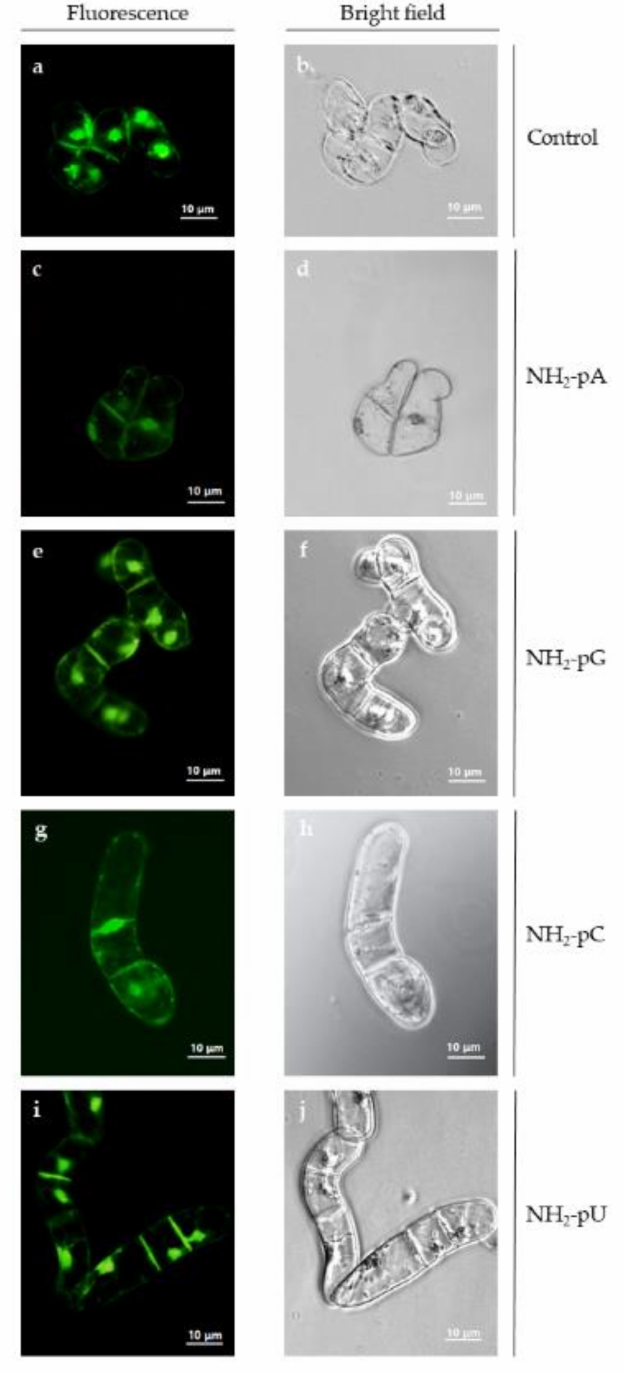
Figure 6. Viability of Vitis vinifera cell suspension culture treated with 5 µ M NH 2 -pNs at 72 h. It was evaluated by incubating cells in the presence or absence of the indicated nucleotide for 1–2 min in fresh Gamborg medium using the Plant Cell Viability Assay Kit (Sigma-Aldrich, Burlington, MA, USA) as described in the Section 4. Fluorescence was observed with an AxioVert 200 Carl Zeiss microscope using a Zeiss filter (FS09 exc = 495 nm, emi = 517 nm). ( a , b ) control cells; ( c , d ) cells treated with NH 2 -pA; ( e ) and ( f ) NH 2 -pG; ( g , h ) NH 2 -pC; ( i , j ) NH 2 -pU. The left-hand column shows cells under the fluorescence microscope, and the right-hand column shows cells under the bright field microscope. No red fluorescence, which indicates cell damage or mortality (FS15 exc = 538 nm, emi = 617 nm) was found (data not